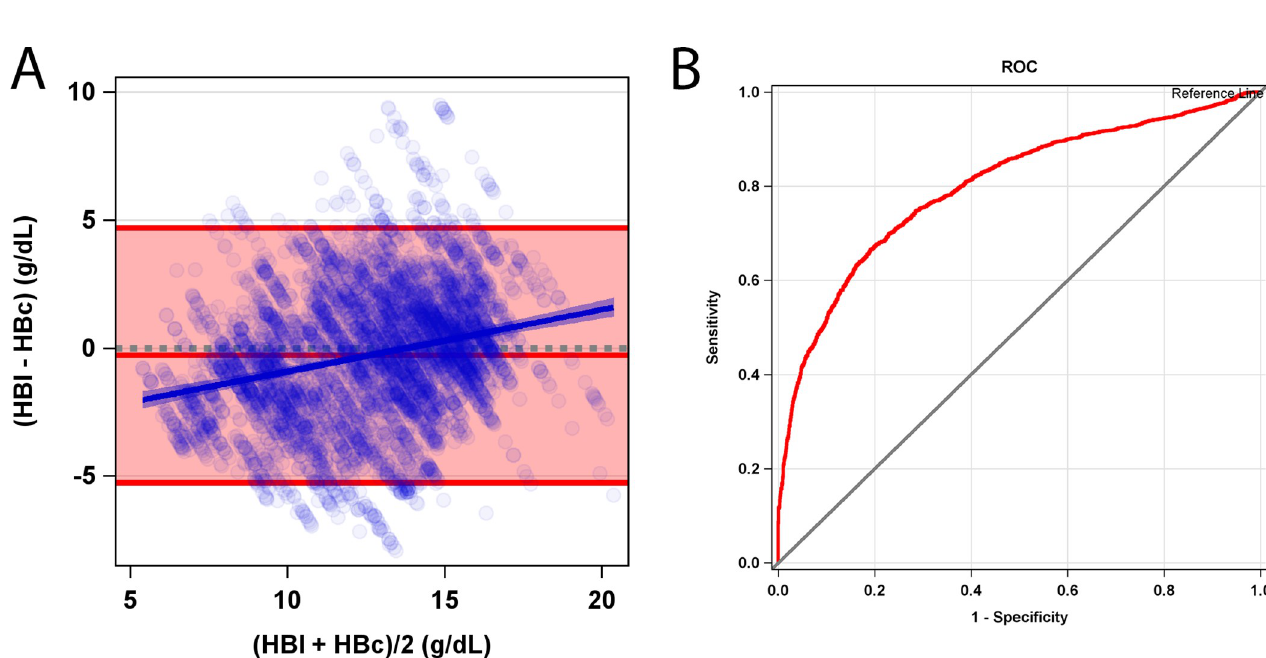
Fig 4. Accuracy results and clinical utility of Phase 2 algorithm validation study. ( A) Bland-Altman plot for HBc compared to HBl for all 344 participants in the Phase 2 validation data. The average hemoglobin concentration (HBl+HBc/2) in g/dL on the x-axis is plotted against hemoglobin concentration error (HBl- HBc) in g/dL on the y-axis. The pink shaded area represents limits of agreement (Bias = -0.3, upper LOA = 4.7, Lower LOA = -5.3). Model fit for error by increasing average hemoglobin concentration is represented by the solid blue line. Blue shaded region represents slope 95% confidence intervals for error fit. Grey dotted line represents 0 error. (B) Receiver Operator Characteristics of HBc using HBl as the gold standard in gender-specific anemia threshold testing. The x-axis depicts 1- Specificity and the y-axis shows the sensitivity. The red line represents the ROC and the black line is the no-discrimination line. Area Under the Curve (AUC) =